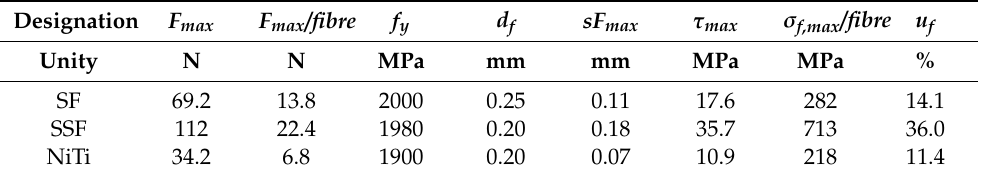
Table 2. Results of the fibre pullout tests for the different fibre types.